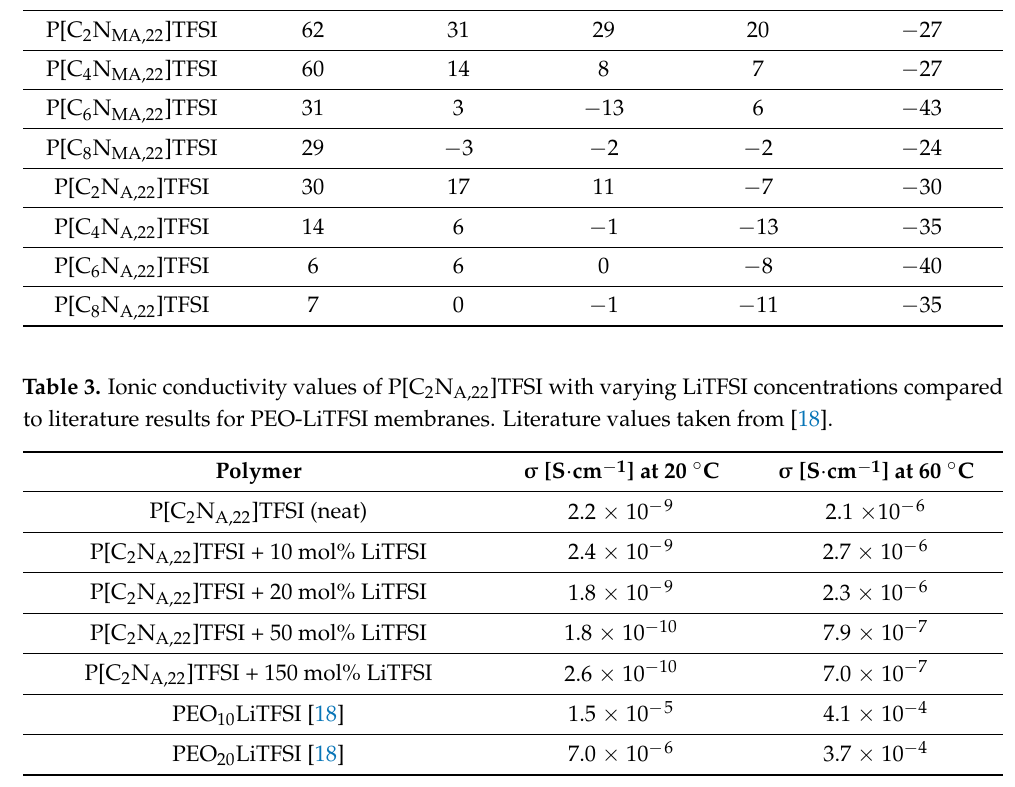
Figure 6. Ionic conductivity values of ( a ) P[C 8 N MA,22 ]TFSI and ( b ) P[C 8 N A,22 ]TFSI polymer membranes in dependence of temperature and LiTFSI concentration. Table 2. Glass transition temperatures of the studied PIL-LiTFSI mixtures. PIL